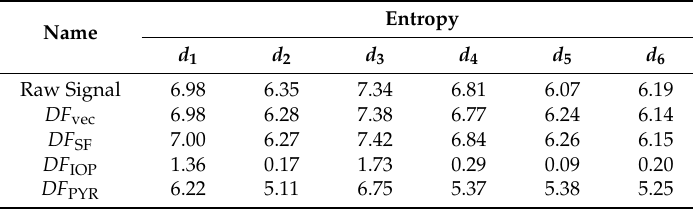
Table 1. Evaluation of data fusion scheme based on entropy E .